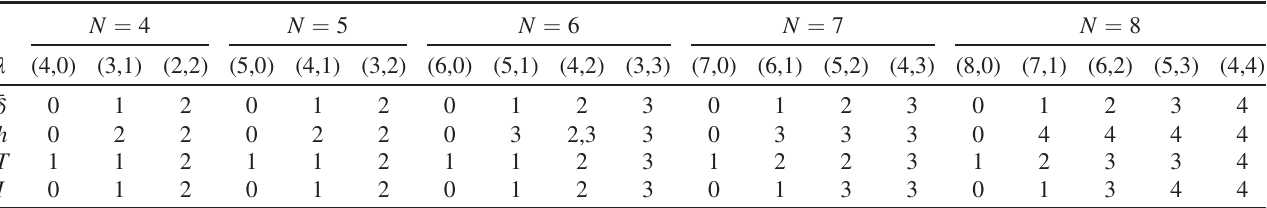
TABLE I. Values of n ð λ Þ , i.e., of the optimal guess for the size of the smallest cluster, where λ ¼ ð λ 1 ; λ 2 Þ are the relevant irreps, for data ¯ δ sizes N ¼ 4 , 5, 6, 7, 8, and cost functions ð x ; x 0 Þ (corresponding to the success probability), Hamming distance h ð x ; x 0 Þ , trace distance T ð x ; x 0 Þ , and infidelity I ð x ; x 0 Þ . N ¼